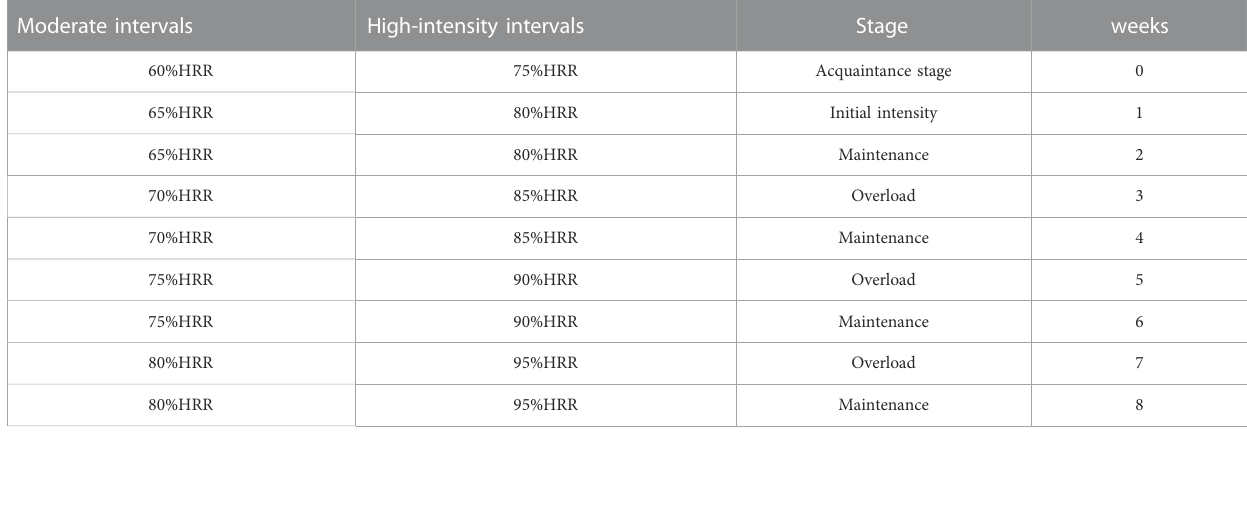
TABLE 3 The characteristics of